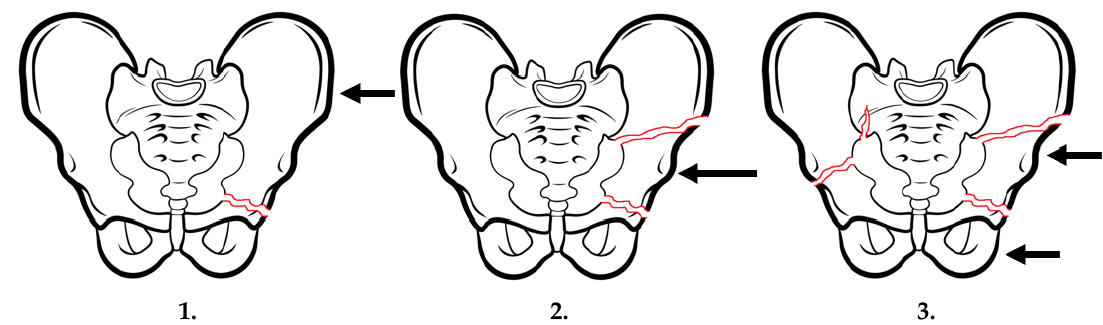
Figure 1. Pelvic injuries caused as a result of side impacts (pelvis side compression). Own study based on [12].